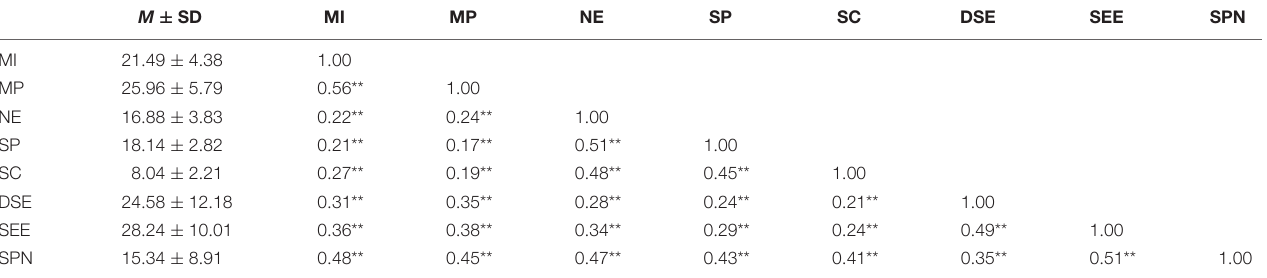
TABLE 4 | Related analysis on college students’ media internalized pressure, social physique anxiety, weight control self-efficacy, and sports participation ( N = 1,194).